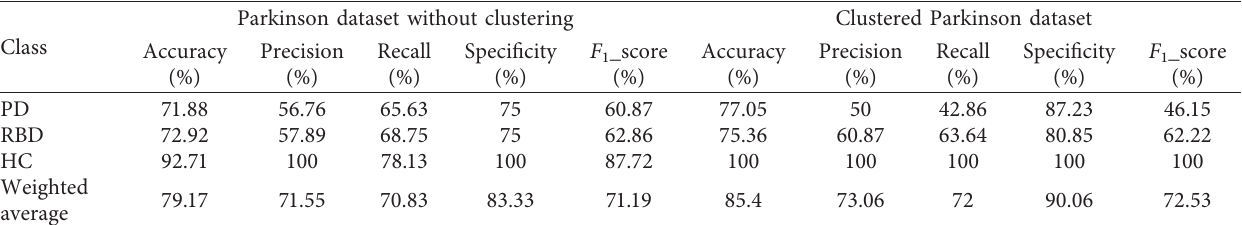
Figure 6: The loss on the training set and the loss on the validation set for the proposed model training. Table 2: A comparison between applying the proposed model on Parkinson dataset without clustering and clustered PD dataset with the performance metrics accuracy, precision, recall, specificity, and f 1 _score.